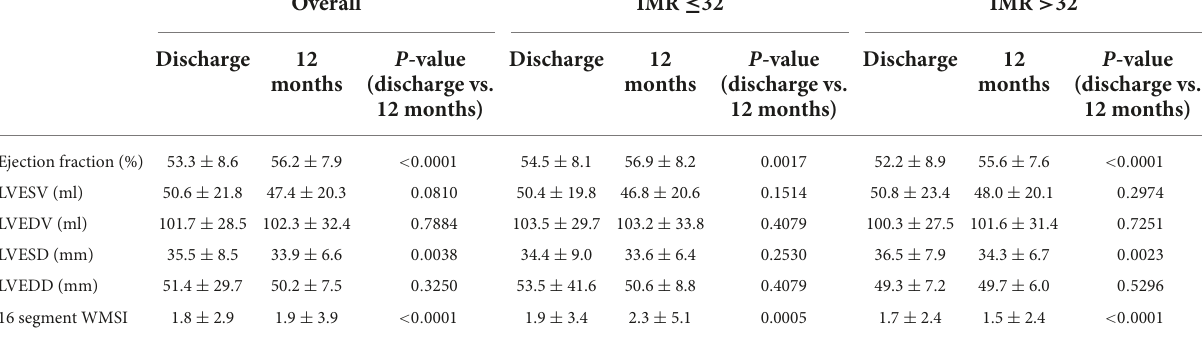
TABLE 2 Echocardiographic